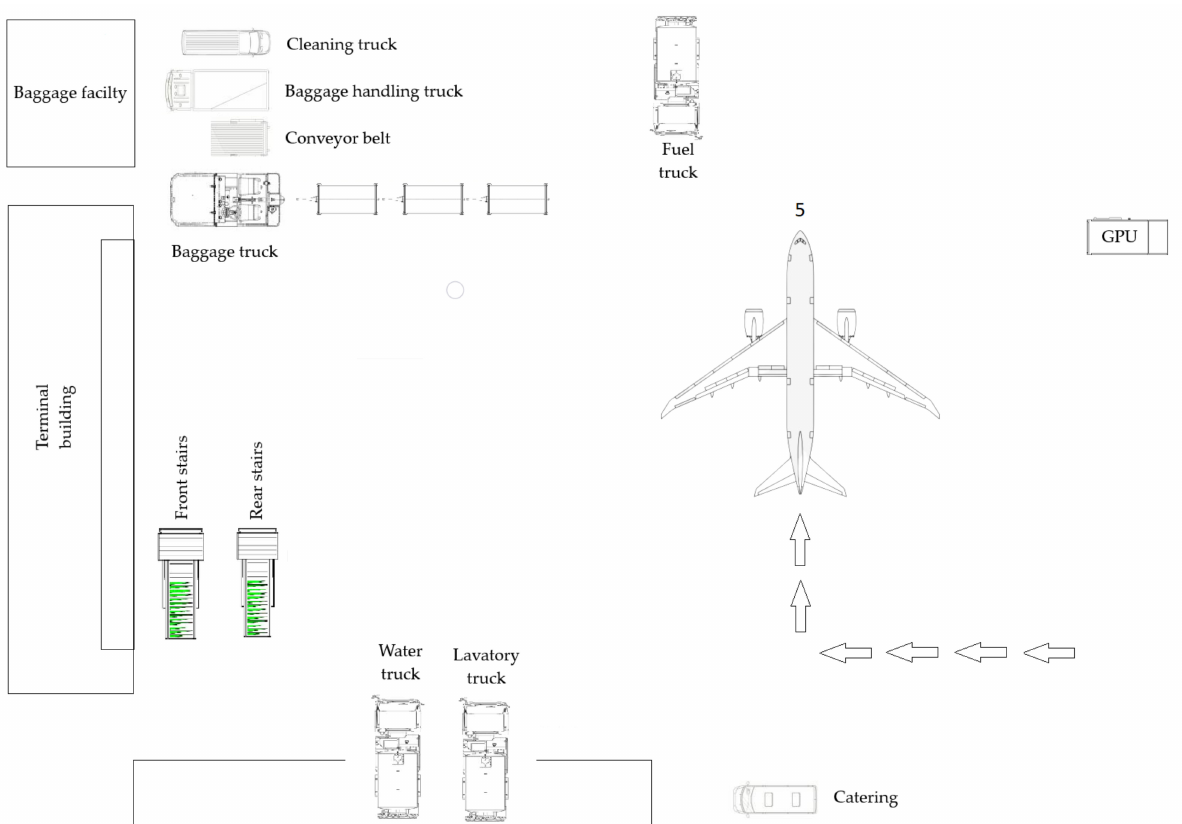
Figure 1. Deployment of ground handling equipment before changes were applied.